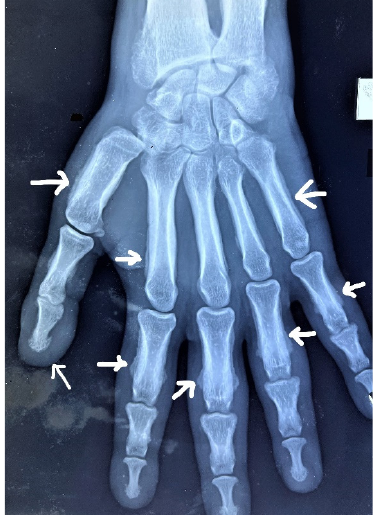
Figure 4. X-ray of hand (2014) showing irregular periosteal hypertrophy with soft tissue swelling Figure 3. Clubbing of the toes, marked with arrows. and new bone formations affecting metacarpal bones and phalanges. New bone formation and soft tissue swelling are marked with arrows.